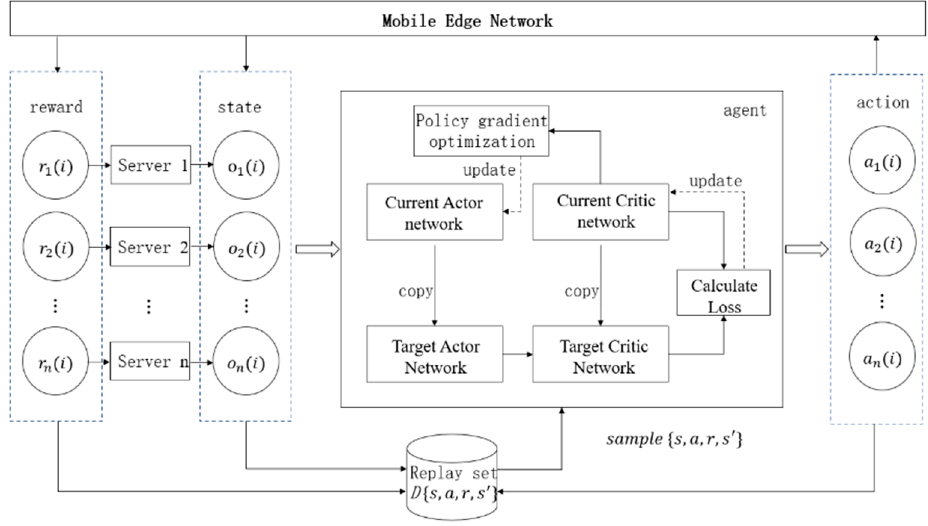
Figure 2. VM Migration Strategy Architecture based on MADRL.